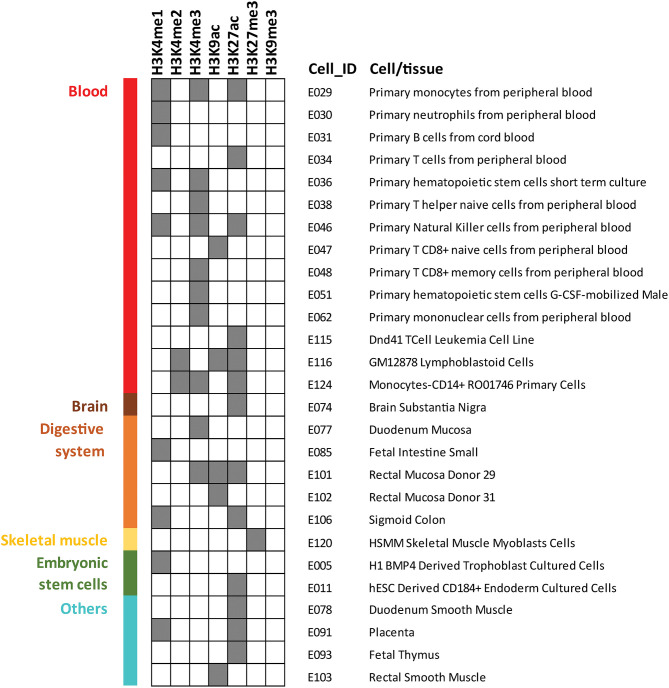
Histone marks enrichment analysis among genetic susceptibility loci previously reported at GWAS level of significance (p-value <5 × 10−8) for Behçet's disease. GenomeRunner was used to perform the enrichment of seven histone marks in 127 cell and tissue types included in Roadmap Epigenomics Consortium and the Encyclopedia of DNA Elements (ENCODE). Dark gray color squares denote statistical significance (corrected p-value < 0.05). Only the 27 cell and tissue types for which significant enrichment was identified for at least one histone mark are displayed.